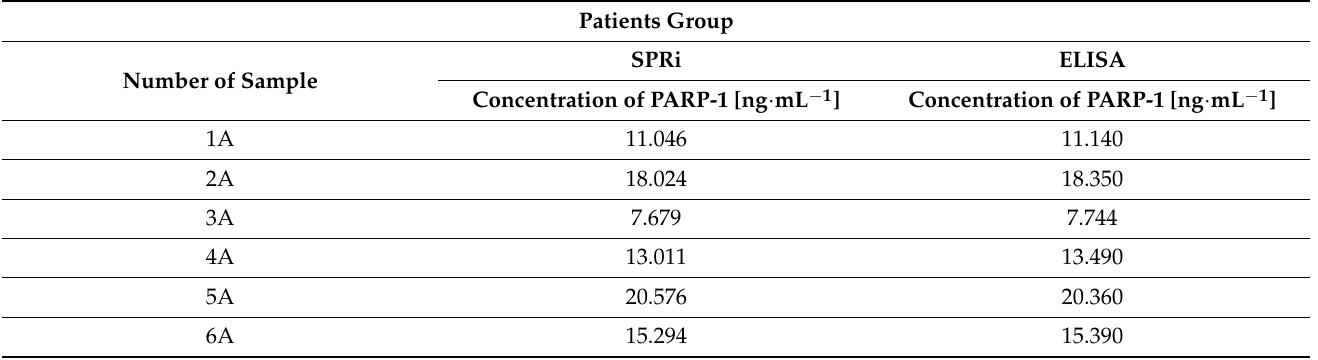
Figure A6. Influence of pH solution on SPRi signal. Concentration of PARP-1 = 5 ng · mL − 1 , antibody concentration = 2 ng ∙ mL − 1 . Table A1. Comparison of results for blood plasma samples from patients with endometriosis (resarch group) and the control group, obtained by the SPRi method and ELISA as the reference method.